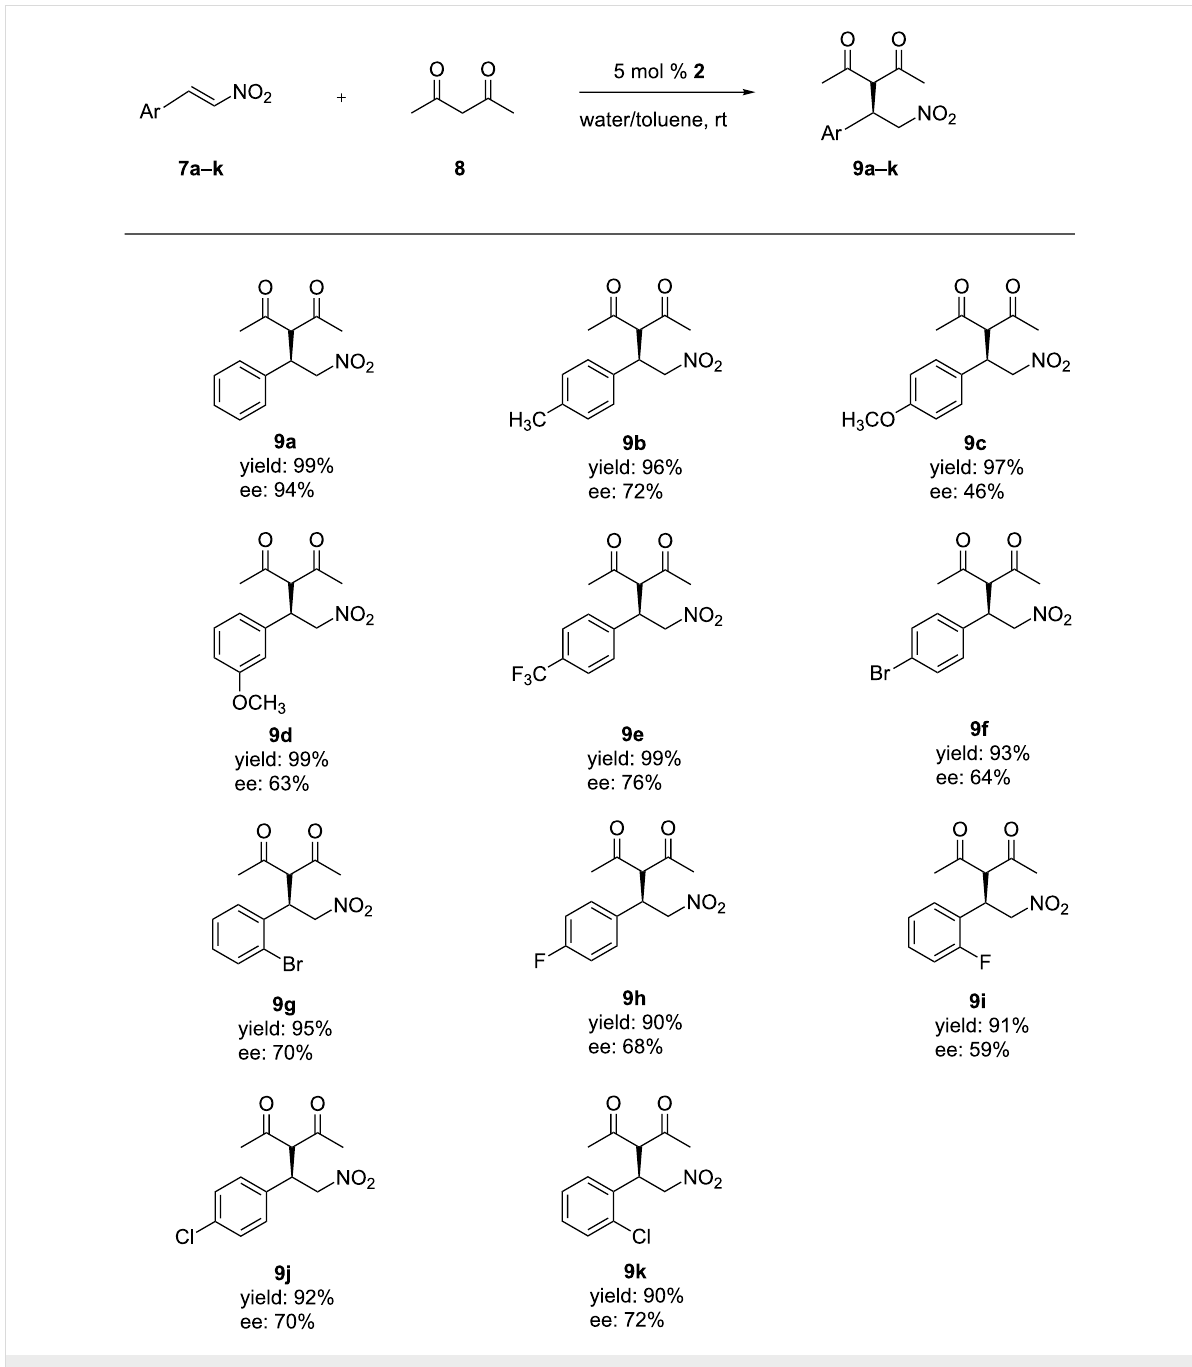
Figure 1: Asymmetric Michael addition of acetylacetone with different nitroolefins catalyzed by organocatalyst 2 . Reagents and conditions: catalyst 2 (5 mol %), nitroolefin (0.5 mmol), acetylacetone (1 mmol), toluene (0.32 mL) and water (0.16 mL), rt.